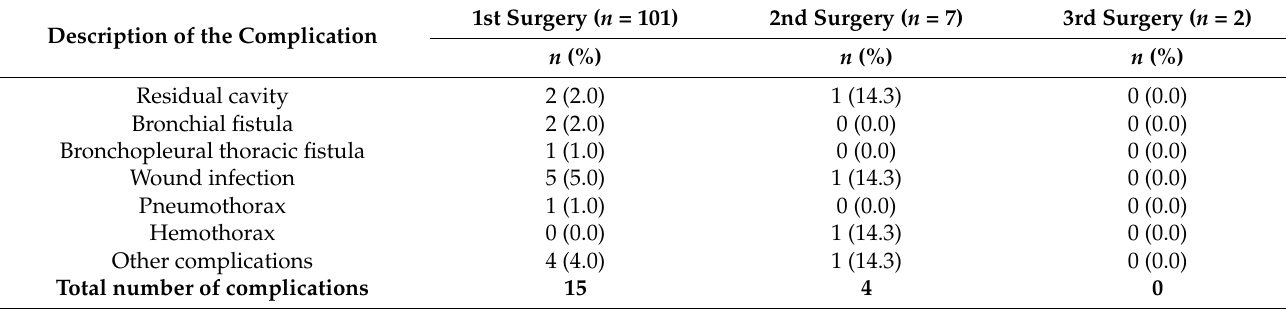
Table 4. Complications of surgery performed in patients with respiratory tuberculosis at RSSPMCPP in Uzbekistan from January to May